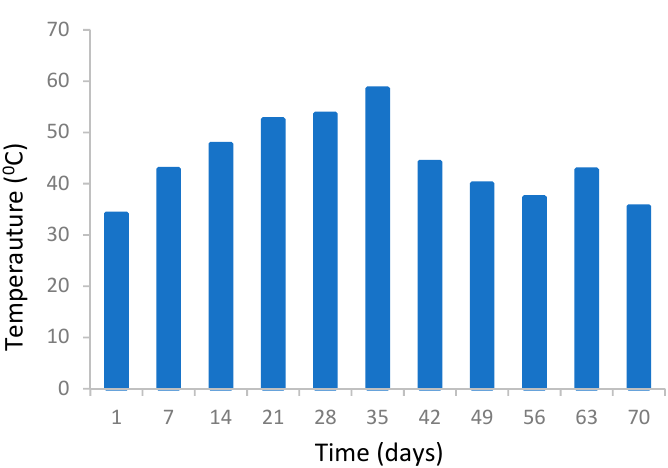
Figure 5. Temperature variations during the composting process in waste mass.